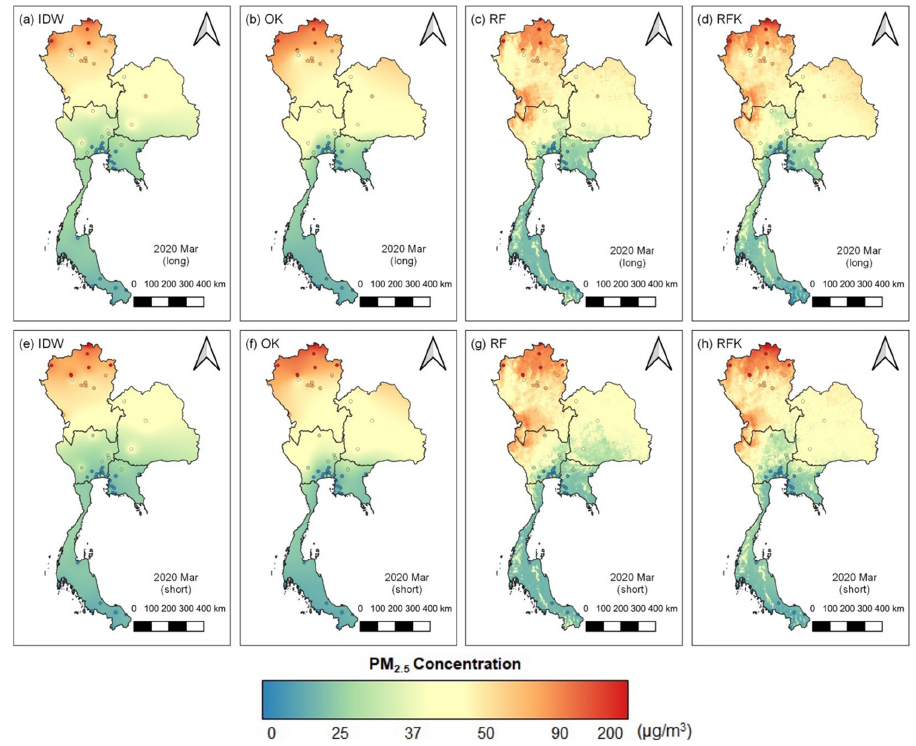
Figure 5. Interpolated PM 2.5 concentrations from different spatial interpolation methods ( a – d ) from 1 to 31 March and ( e – h ) from 19 to 29 March.